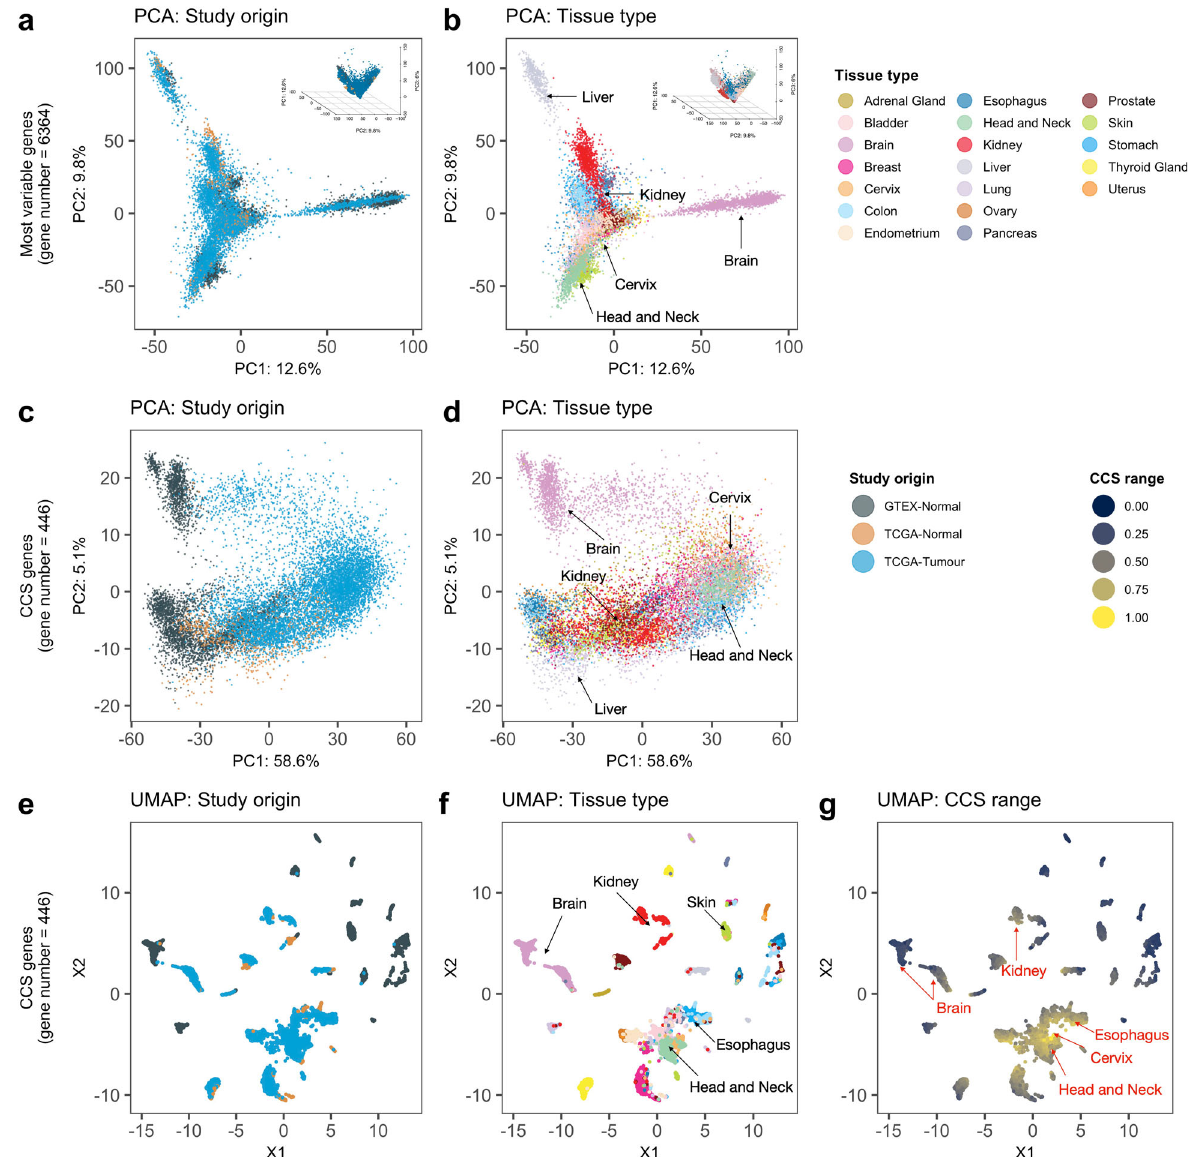
Fig. 2 PCA and UMAP dimensionality reduction of GTEx and Pan-Cancer Atlas datasets. Toil pipeline batch-corrected mRNA expression data from the GTEx and TCGA pan-cancer datasets ( N = 13117 in total) were used to perform. a Principle component analyses (PCA) using the most variable genes in the dataset with an overlay of colours based on study origin or b tissue type; c PCA using the genes of the CCS signature with an overlay of colours based on study origin or d tissue type; e Uniform Manifold Approximation and Projection (UMAP) using the genes of the CCS signature with an overlay of colours based on study origin or f tissue type or g CCS